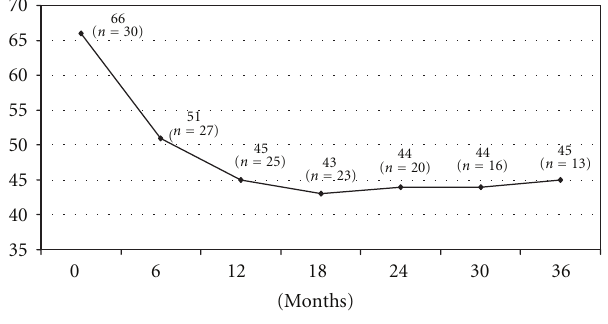
Figure 2: BMI evolution (Kg/m 2 ).